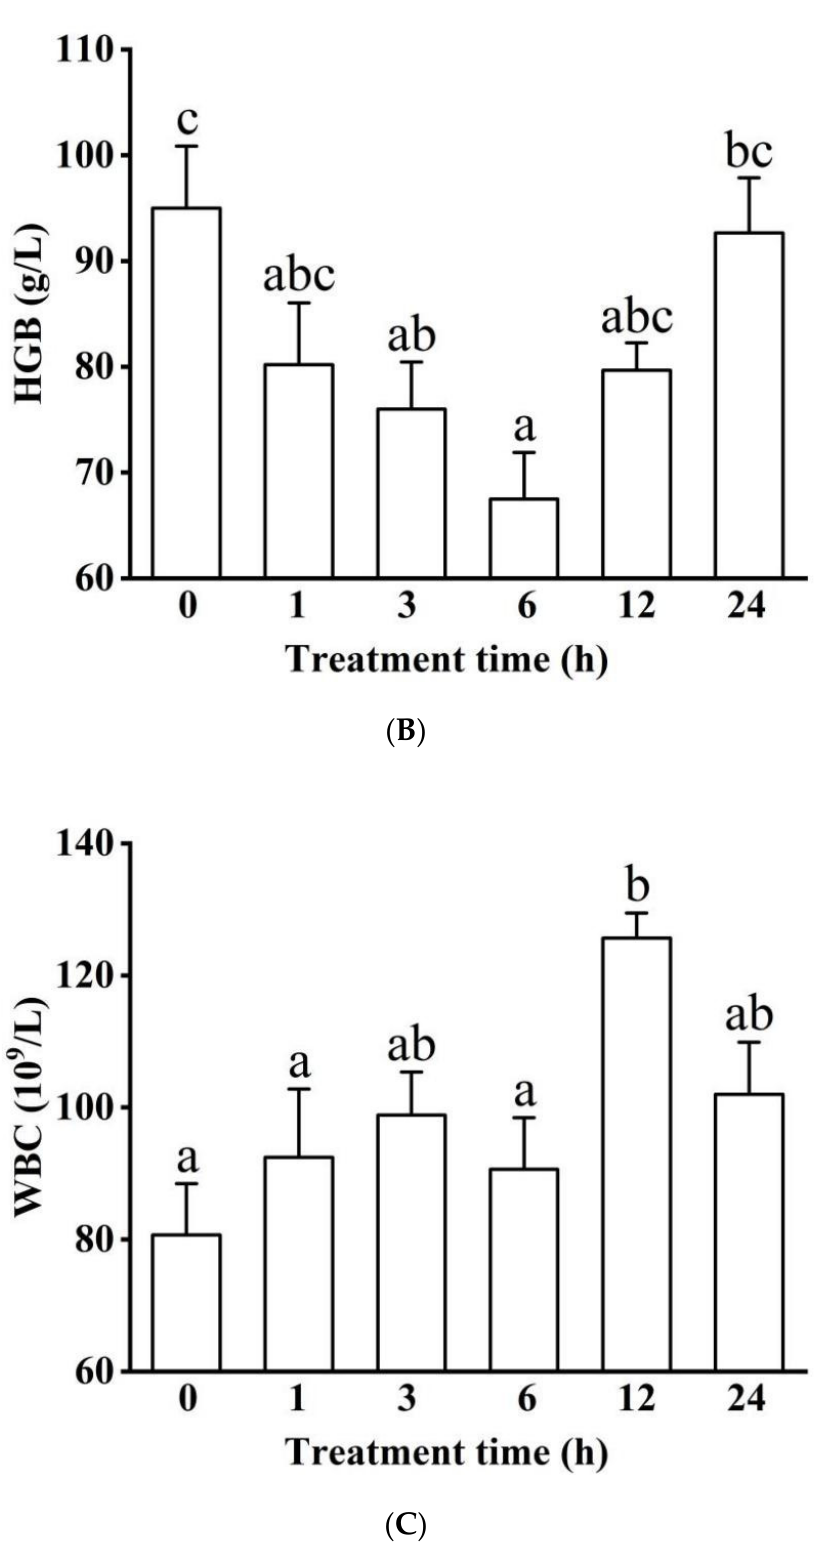
Figure 1. Effects of acute hypoxia on blood physiological indicators (red blood cell (RBC) concen- tration ( A ), hemoglobin (HGB) concentration ( B ), and white blood cell (WBC) concentration ( C ) in Japanese flounder ( Paralichthys olivaceus ). There was no significant difference in RBC concentration among the six treatment groups. Different letters indicate significant differences ( p < 0.05).